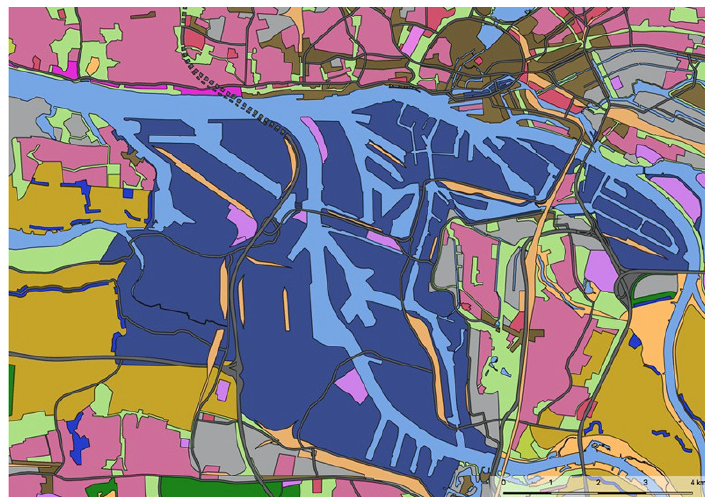
Figure 9. Official zoning plan/land use plan for the City of Hamburg of 2020. Similar to the land use data set ATKIS, the port is defined as ‘Hafen’ (blue), but not further specified. Source: Stadtentwicklung und Wohnen Hamburg